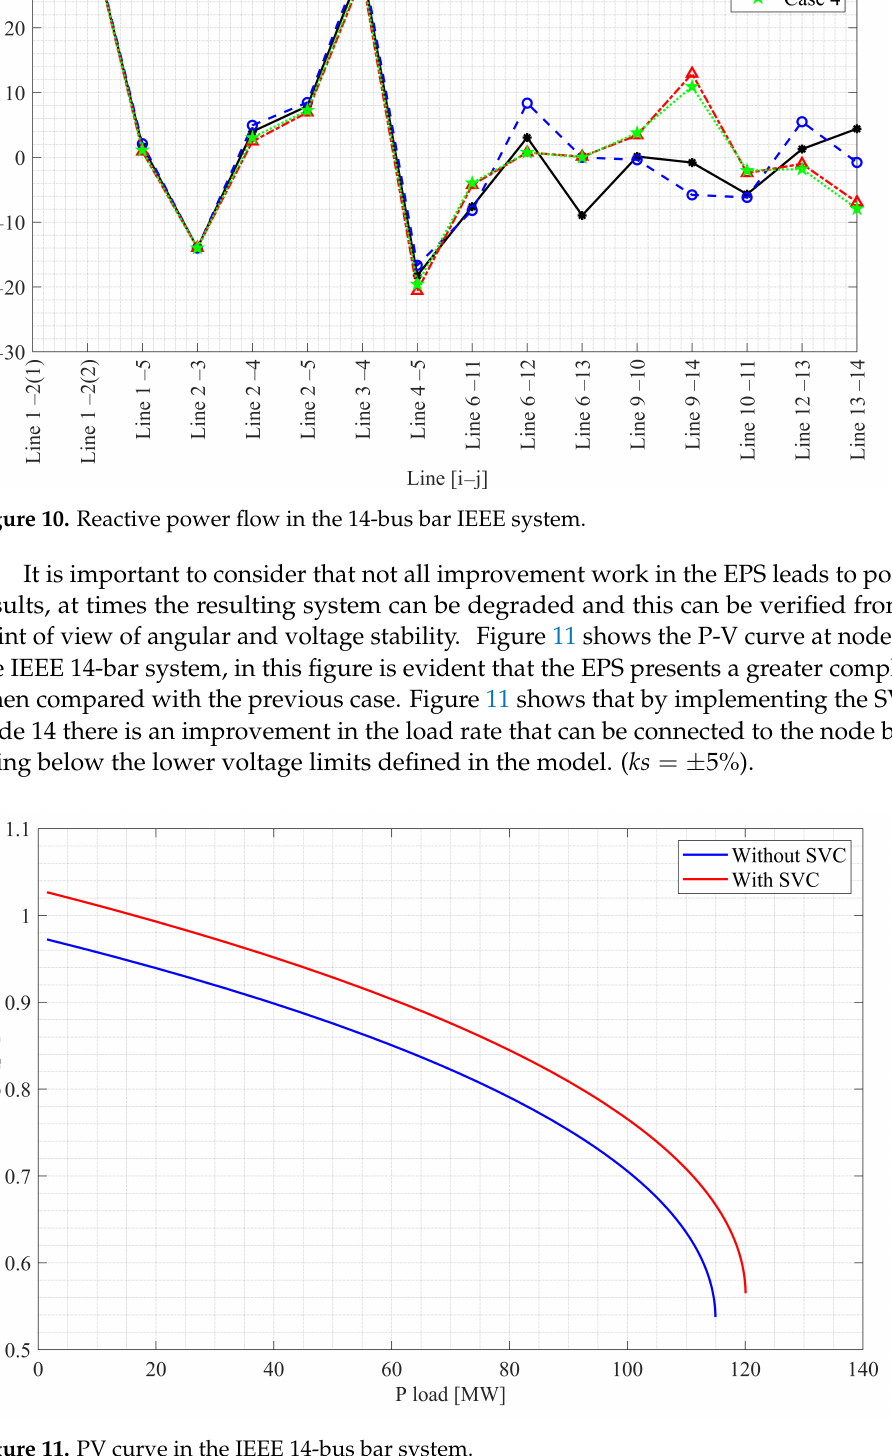
Figure 11. PV curve in the IEEE 14-bus bar